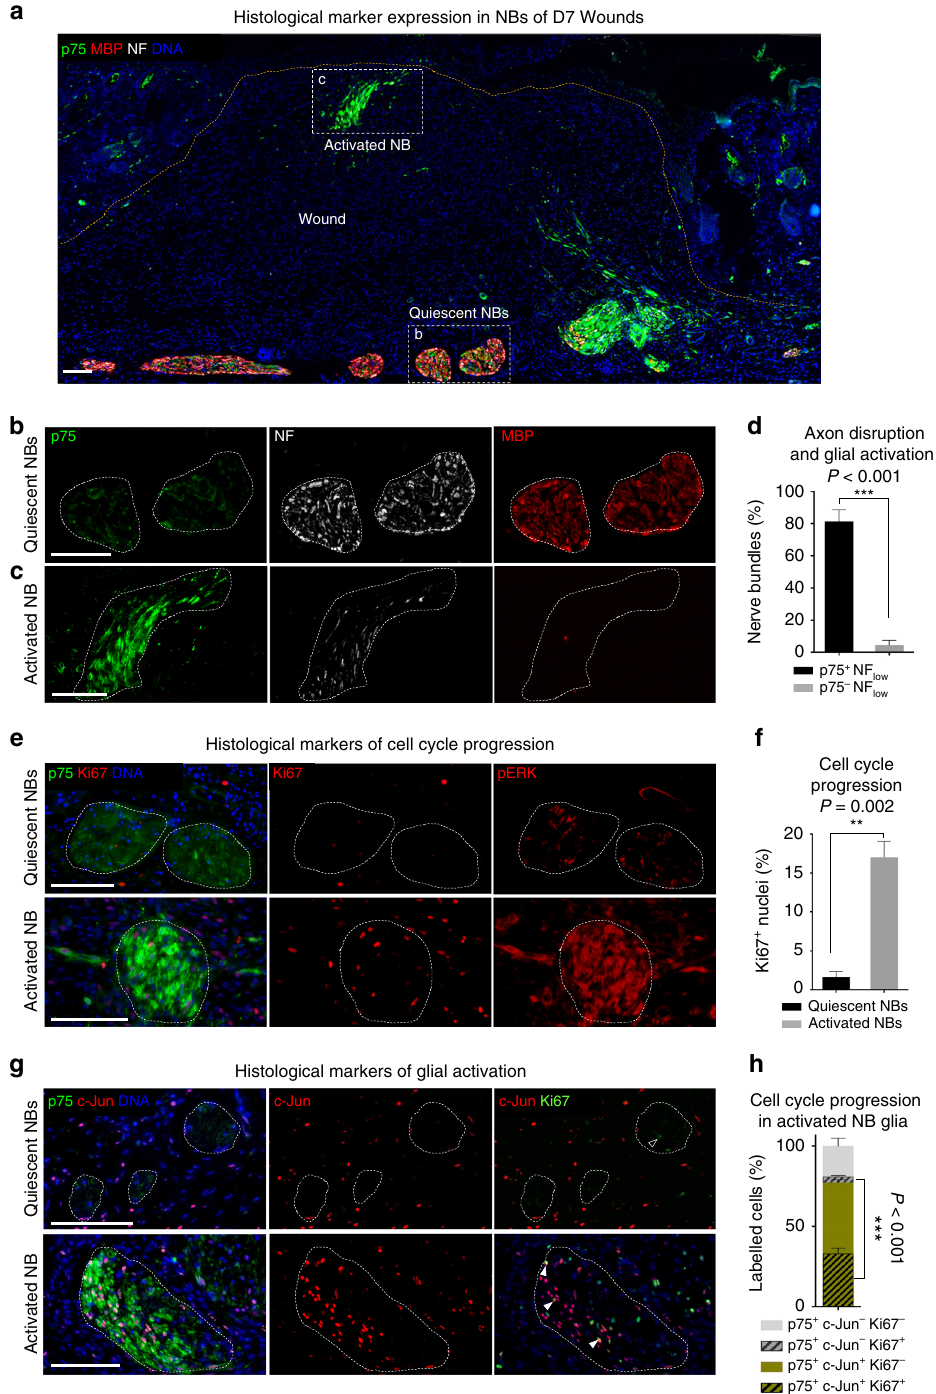
Fig. 2 Skin injury induces peripheral glial de-differentiation and proliferation. a p75 (green), MBP (red), and NF (white) triple immunolabelling of wound sections shows increased expression of the de-differentiation marker p75 and loss of the differentiation marker MBP as well as loss of NF in activated NBs. b , c Single-channel insets show expression of p75, MBP, and NF in activated and quiescent NBs in injured skin. d Quanti fi cation of NBs categorised based on NF labelling (NF High and NF low ) and p75 positivity (p75 + and p75 − ). e Immunolabelling of pERK (marker of activated MAPK signalling pathway) and Ki67 (marker for proliferative or cycling state) (red) in quiescent vs. activated NBs in injured skin. Activated NBs are characterised by p75 staining (green). f Quanti fi cation of Ki67 + nuclei in quiescent or activated NBs. g Double immunolabelling of p75 (green) and c-Jun (red) shows concomitant upregulation of both markers in activated vs. quiescent NBs in injured skin. Black arrowhead denotes a Ki67 + c-Jun − cell. White arrowheads denote Ki67 + c-Jun + cells. h Quanti fi cation of proportion of proliferative (Ki67 + ) cells in c-Jun + and c-Jun − fractions of de-differentiated (p75 + ) glial cells within NBs. Data are represented as mean ± SEM of N = 7 animals, n = 12 wounds for activated NBs and N = 5, n = 9 for quiescent NBs ( d ); 8 quiescent NBs from N = 2, n = 4 and 14 activated NBs from N = 4, n = 6 ( f ); N = 6, n = 7 ( h ). Scale bars, 100 µ m. Wound samples are D7 post